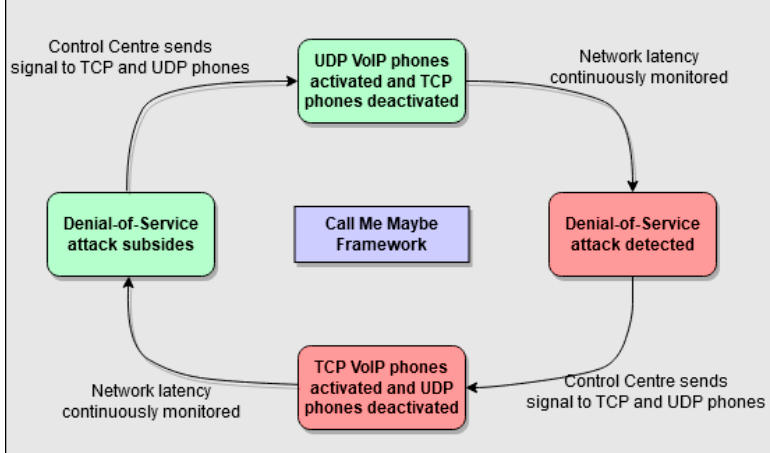
Figure 4. Diagram of the processes involved in the Call Me Maybe framework.